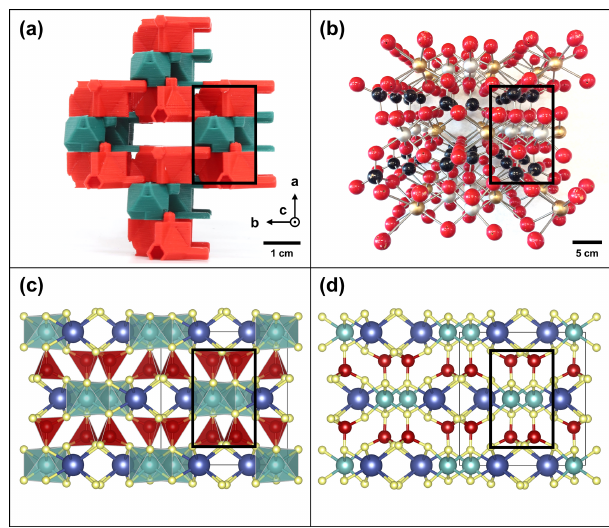
Figure 11. Comparison of the different representations of the crys- tal structure of diopside (Cameron et al., 1973), a member of the clinopyroxenes, looking down the c axis: (a) TotBlocks (pho- tographed), (b) physical ball-and-stick models (photographed), and (c) – (d) virtual polyhedral and ball-and-stick models rendered using the visualization software VESTA (Momma and Izumi, 2011). Note that the structures are approximately equivalent (solid black rectan- gles highlight a single-chain-width T - O - T module); the scale bar denotes the actual sizes of the